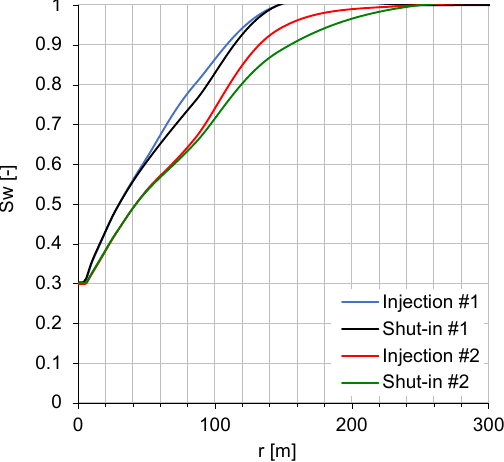
Figure 10. Water saturation profiles in the cases described in Figure 8. The radial saturation distributions (Figure 10) shed light on the complementary ef- fect: CO 2 saturation front moves not only during injection, but also during well shut-in periods. This growth of plume volume is governed by CO 2 expansion due to pressure equilibration during shut-in periods. The growth becomes more visible, when the satura- tion profile is transformed into pore volumes occupied by CO 2 (Figure 11). The observed initial increase of the pore volumes is governed by radial grid with growing grid block volume with radius. The plume volume grows at about 10% during the first shut-in and more than 20% at the second one.